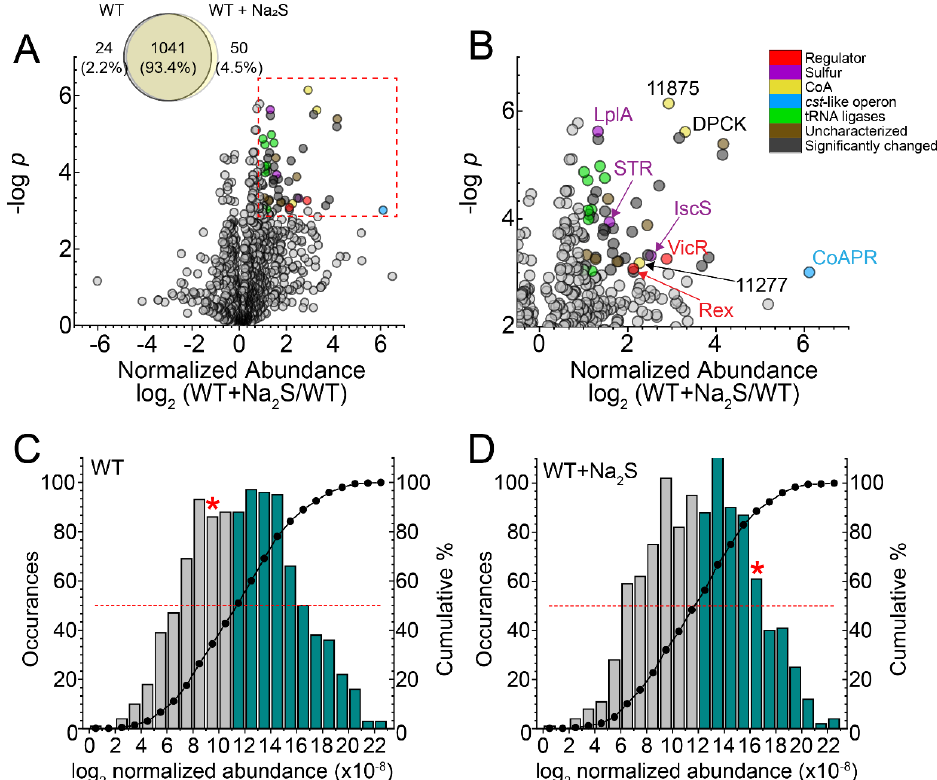
Figure 1. LC-MS/MS proteomics analysis of wild-type E. faecalis . Protein profiles of untreated (WT) vs. 0.2 mM Na 2 S-treated (WT + Na 2 S) E. faecalis cells from four biological replicates. ( A ) Venn diagram of proteins detected at least twice in four biological replicates, with volcano plot for proteins detected at least two times in four biological replicates. The significance threshold was set at p < 0.001 and fold-change in protein abundance at >2, as enclosed in the red dashed-line box. Circles corresponding to proteins within this significance threshold are shaded according to the annotated function in panel B. ( B ) Expanded view of proteins within a significance threshold, shaded according to the annotated function, with select proteins annotated with the protein name or locus tag (OG1RF_xxxxx). Histogram plot of the distribution of normalized abundance for all proteins detected in the ( C ) WT and ( D ) WT+ 0.2 mM Na 2 S strains. The top-most 50% abundant proteins are indicated with a red dashed line, with the bars shaded blue. The red star (*) indicates the cellular abundance of CoAPR.